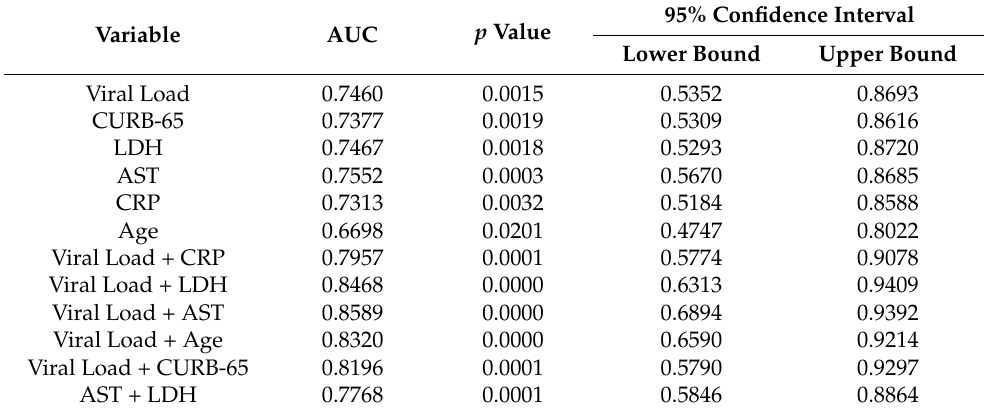
Table 3. Area under the curve for various factors in COVID-19